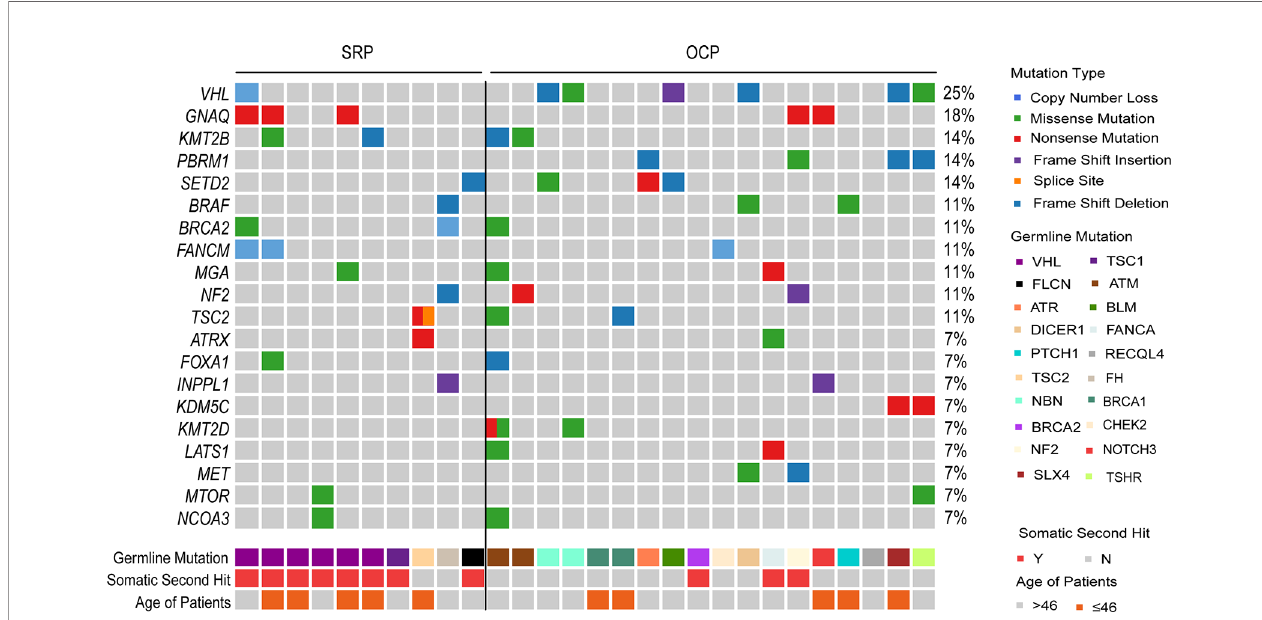
FIGURE 3 | Somatic mutation spectrum of RCC patients with PGVs. Somatic alteration Landscape of 28 RCC patients with PGVs. Top heatmap, distribution of RCC-associated cancer genes and top 20 genes across samples, with genes ranked by mutation frequency. Middle heatmap shows germline mutation genes with somatic hit events presented in the next line. Bottom heatmap shows patient